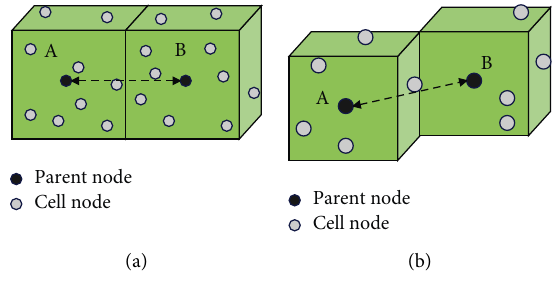
Figure 9: Adjacent cells.